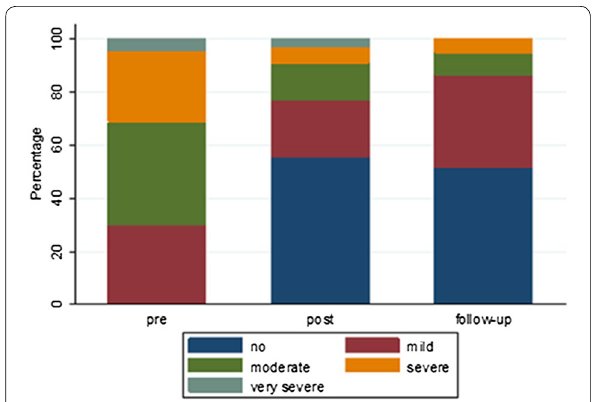
Fig. 1 Severity of depressive symptoms, categorised based on QIDS